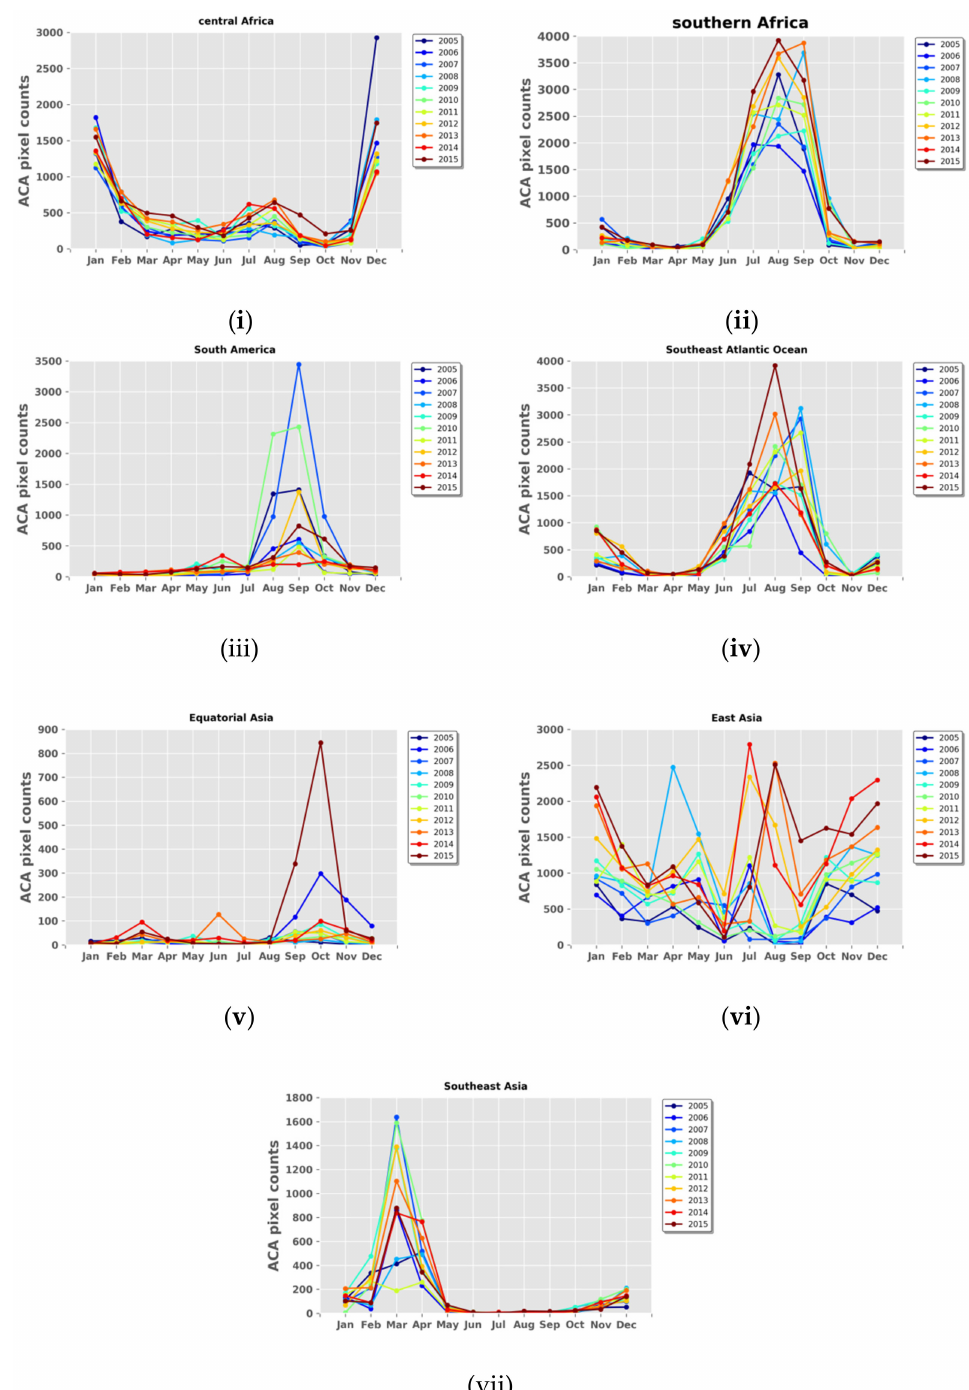
Figure 6. Intra-annual variability, for each year of the period 2005–2015, of the absolute frequency of occurrence of absorbing carbonaceous aerosols (ACA) over the 1 ◦ × 1 ◦ grid cells of each selected world region. Results are given for: ( i ) Central Africa, ( ii ) Southern Africa, ( iii ) South America, ( iv ) Southeast Atlantic Ocean, ( v ) Equatorial Asia, ( vi ) East Asia and ( vii ) Southeast Asia and refer to the overall number of grid cells (counts) over which ACA have been detected by the satellite algorithm during each